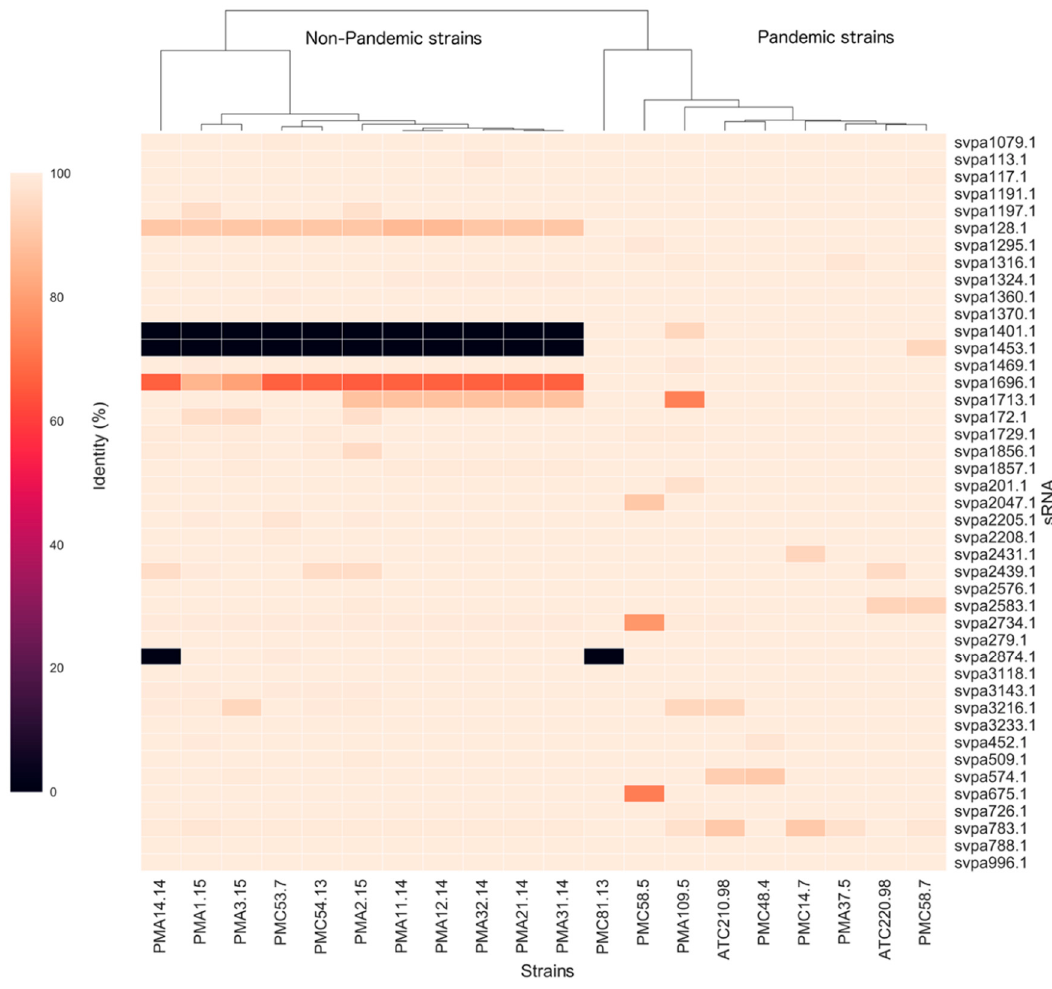
Figure 2. Percentage heat map of sRNA identity sequences showing differences between V. parahaemolyticus strains compared to sRNA sequences reported for reference strain RIMD2210633. Color gradient represents 0% (black) to 100% (skin color) of identity in twenty strains. The dendrogram was constructed using the Euclidean method to cluster the main groups. Table 1. Chilean V. parahaemolyticus strains analyzed in this study.